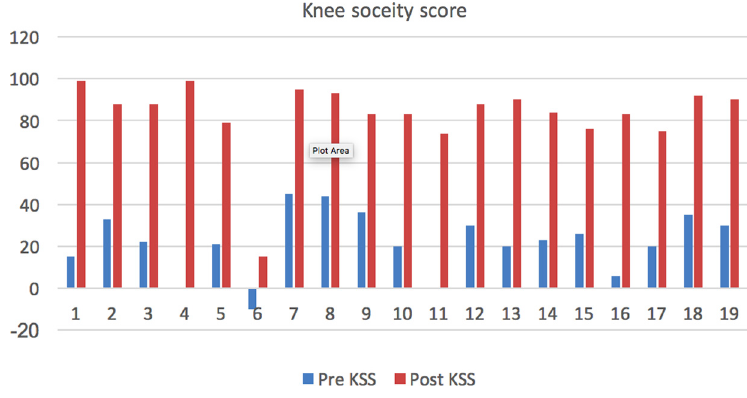
Figure 4. Knee Society score – pre and postop.